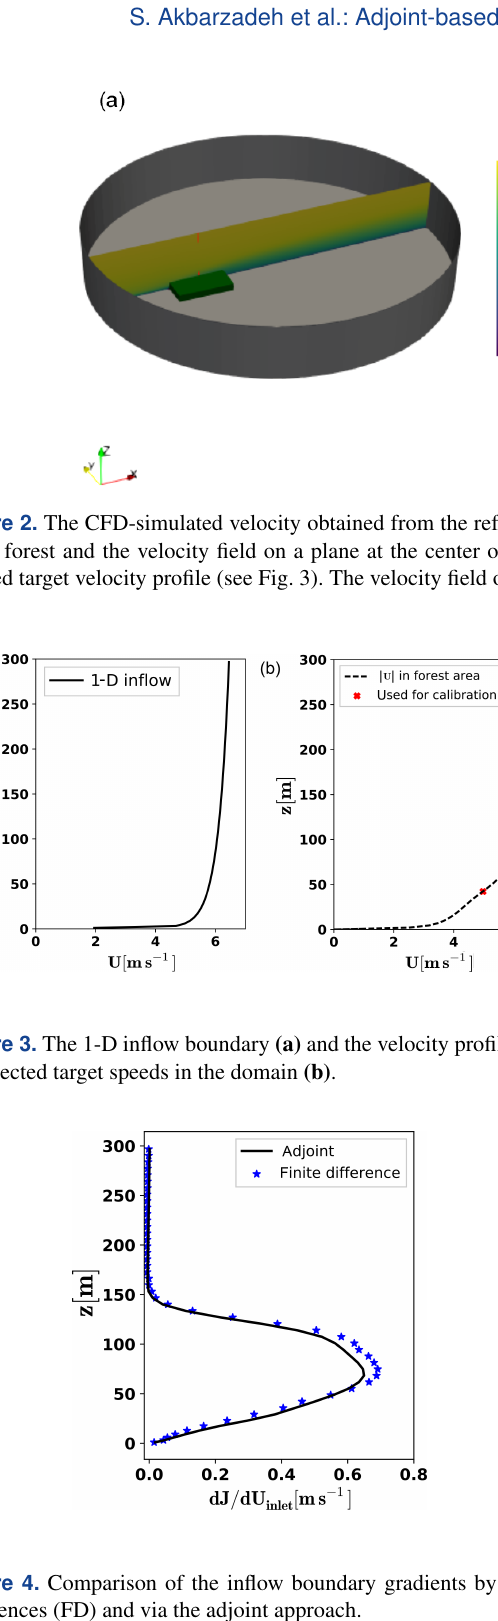
Figure 4. Comparison of the inflow boundary gradients by finite differences (FD) and via the adjoint